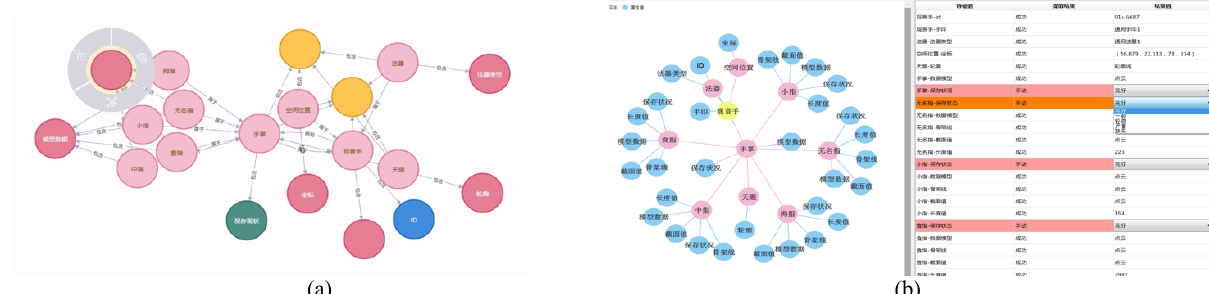
Figure 6. A knowledge graph built through knowledge services